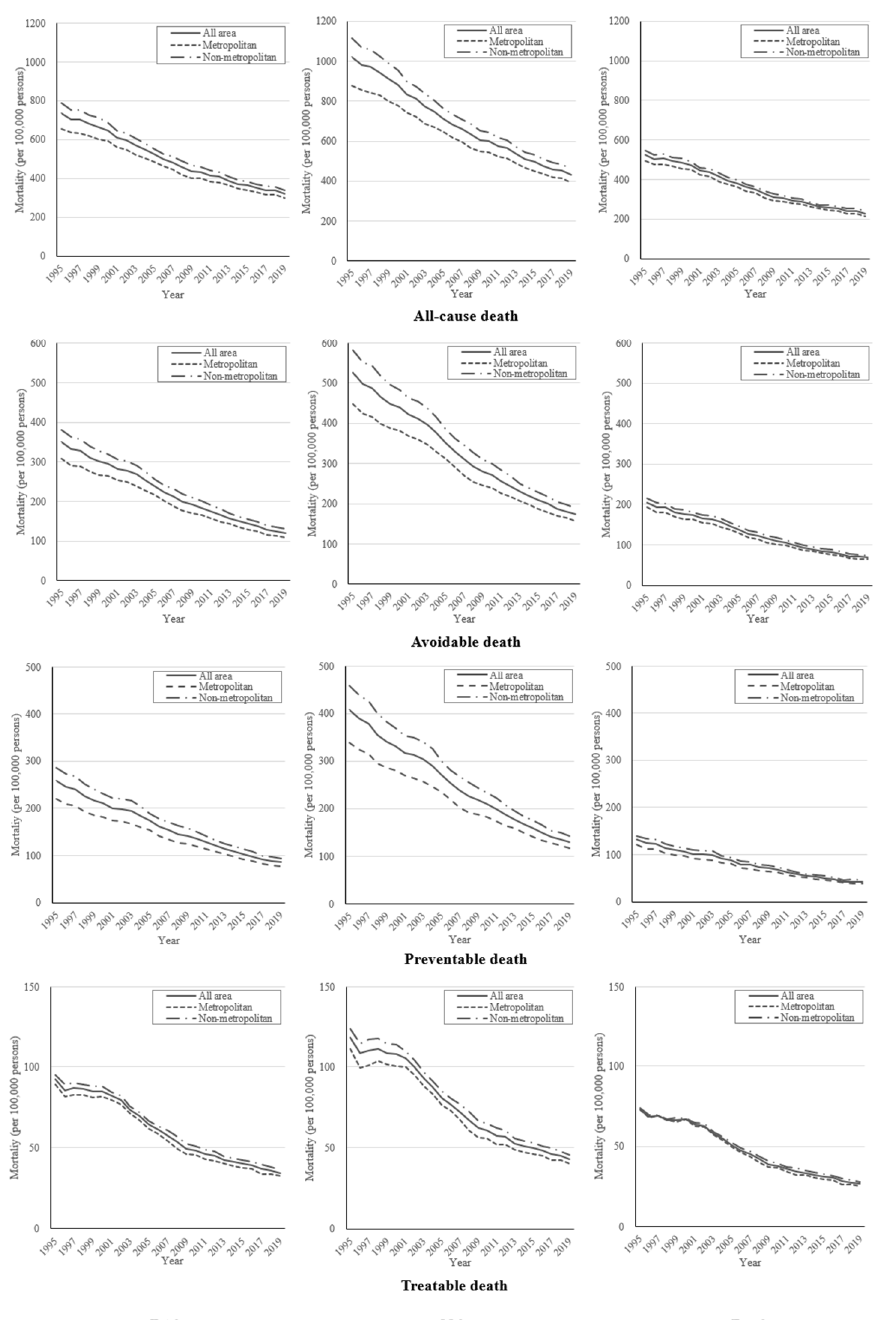
Figure 1. Age standardized all-cause, avoidable, preventable, and treatable mortality rates of metropolitan and non-metropolitan areas by sex from 1995 to 2019.